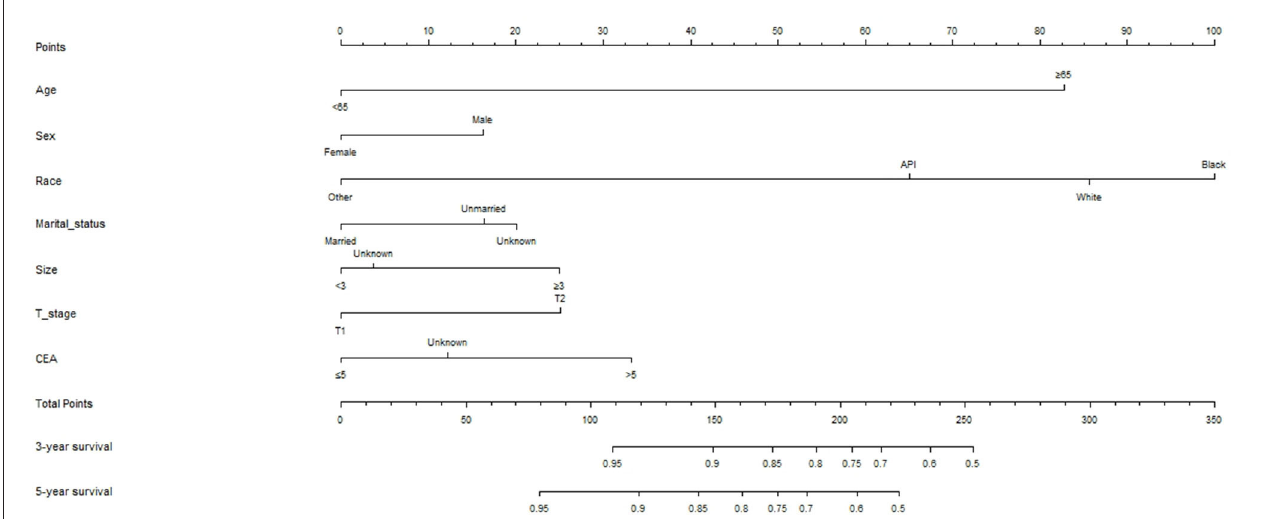
FIGURE 3 | Oncologic nomogram for patients with stage I rectal cancer after local excision.